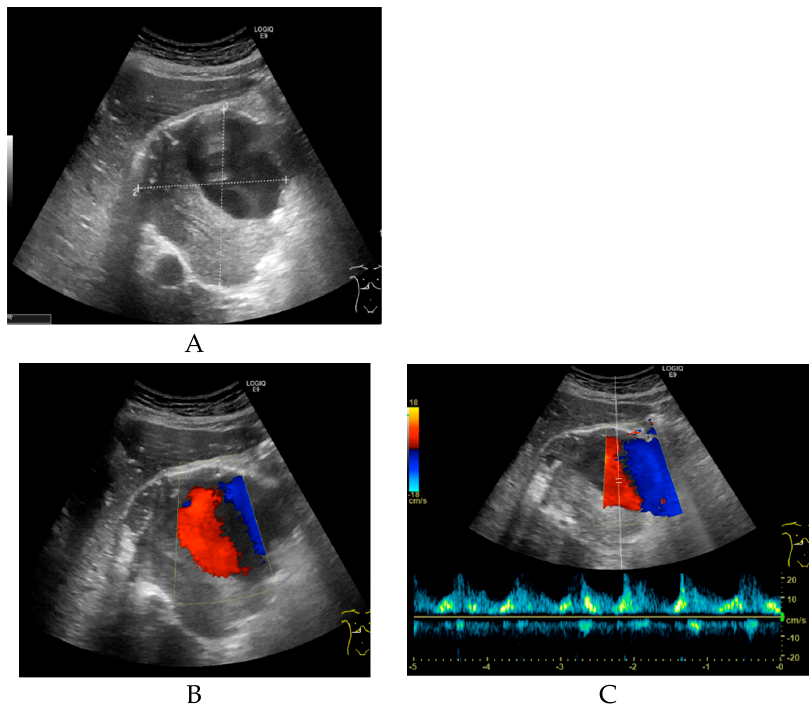
Figure 2. ( A ) Transverse grey-scale ultrasound of the porta hepatis reveals a large, well-defined sonolucent mass measuring approximately 9.7 × 9.4 × 9.1 cm. The upper part of the lesion shows an anechoic lumen, and the lower part of the lesion contains intraluminal echogenic material suggestive of thrombus. ( B ) Transverse color Doppler ultrasound shows a turbulent arterial flow pattern in the upper part of the lesion. ( C ) Pulsed wave Doppler sonogram shows an arterial waveform with high peak systolic velocity consistent with a hepatic artery aneurysm.